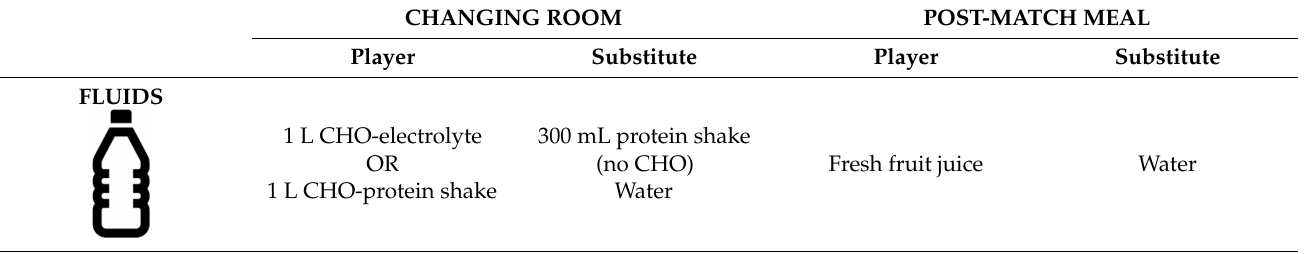
Table 4. Some ideas for nutritional support in the changing room after a match and for a post- match